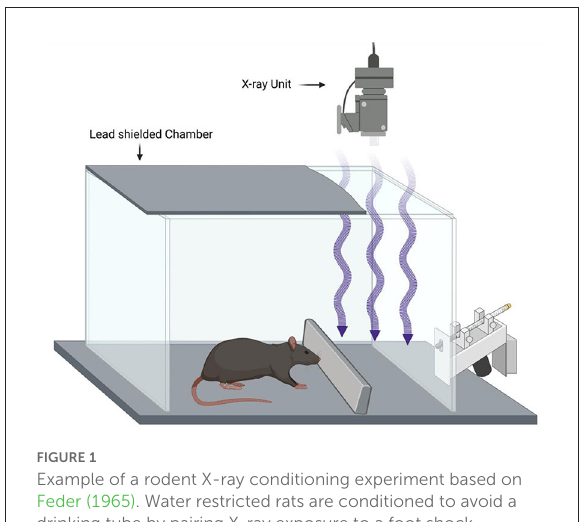
FIGURE1 Example of a rodent X-ray conditioning experiment based on Feder (1965). Water restricted rats are conditioned to avoid a drinking tube by pairing X-ray exposure to a foot shock (unconditioned stimulus) providing evidence that the rats can make use of the X-ray exposure as a conditioned stimulus. Blocking the X-rays with lead prevents the effect showing that the X-rays are the conditioned stimulus and not some other